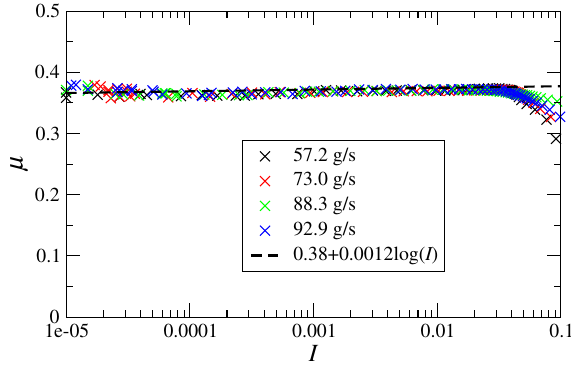
Figure 5. Variation of friction coe ffi cient ( µ ) with inertial num- ber ( I )